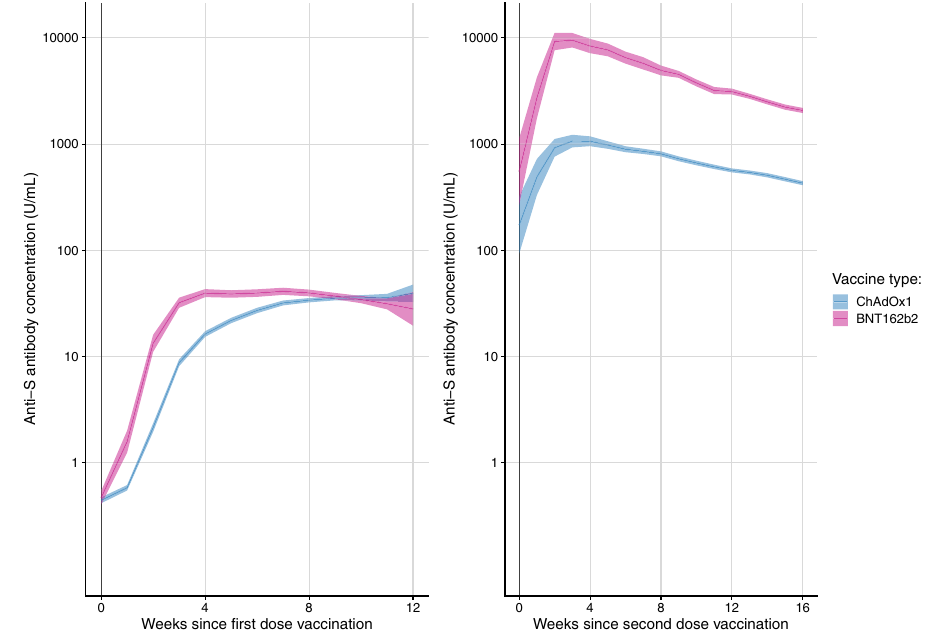
Fig.1|S-antibodylevelsovertimefollowingthe fi rstdose(left)andthesecond dose (right) of COVID-19 vaccination. Geometric means and 95% con fi dence intervals of Spike-antibody (U/ml) for each week since receiving fi rst and